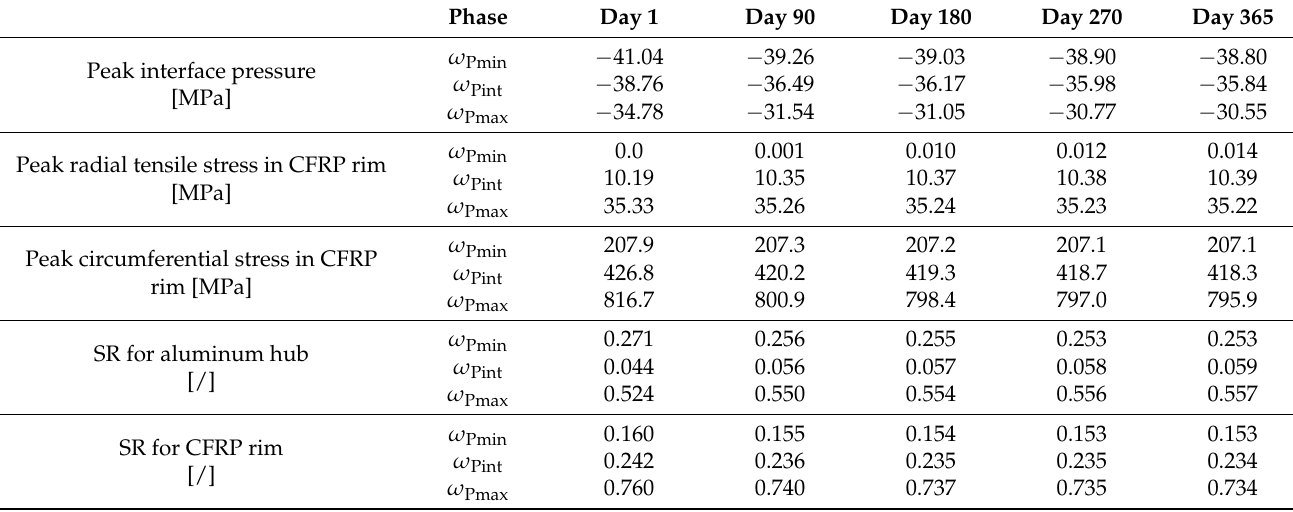
Figure 7. SR graphs for all points along the flywheel rotor radius at each velocity on day 1. Table 5. Peak stress values at the hub-rim interface and radially and circumferentially in the CFRP rim, and peak SR values for the aluminum hub and the CFRP rim, at various times throughout the simulated one-year period. Phase Day